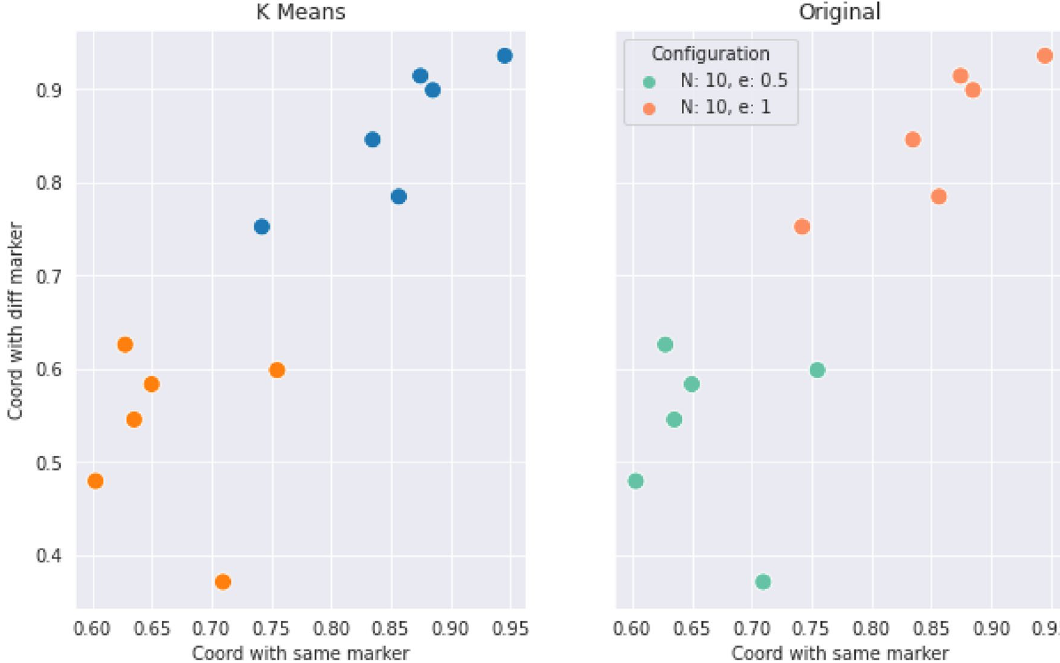
Figure 4. K-Means clustering for the groups that have a size of N = 10 participants. The separation confirms that the space of parameters of coordination rate separates the